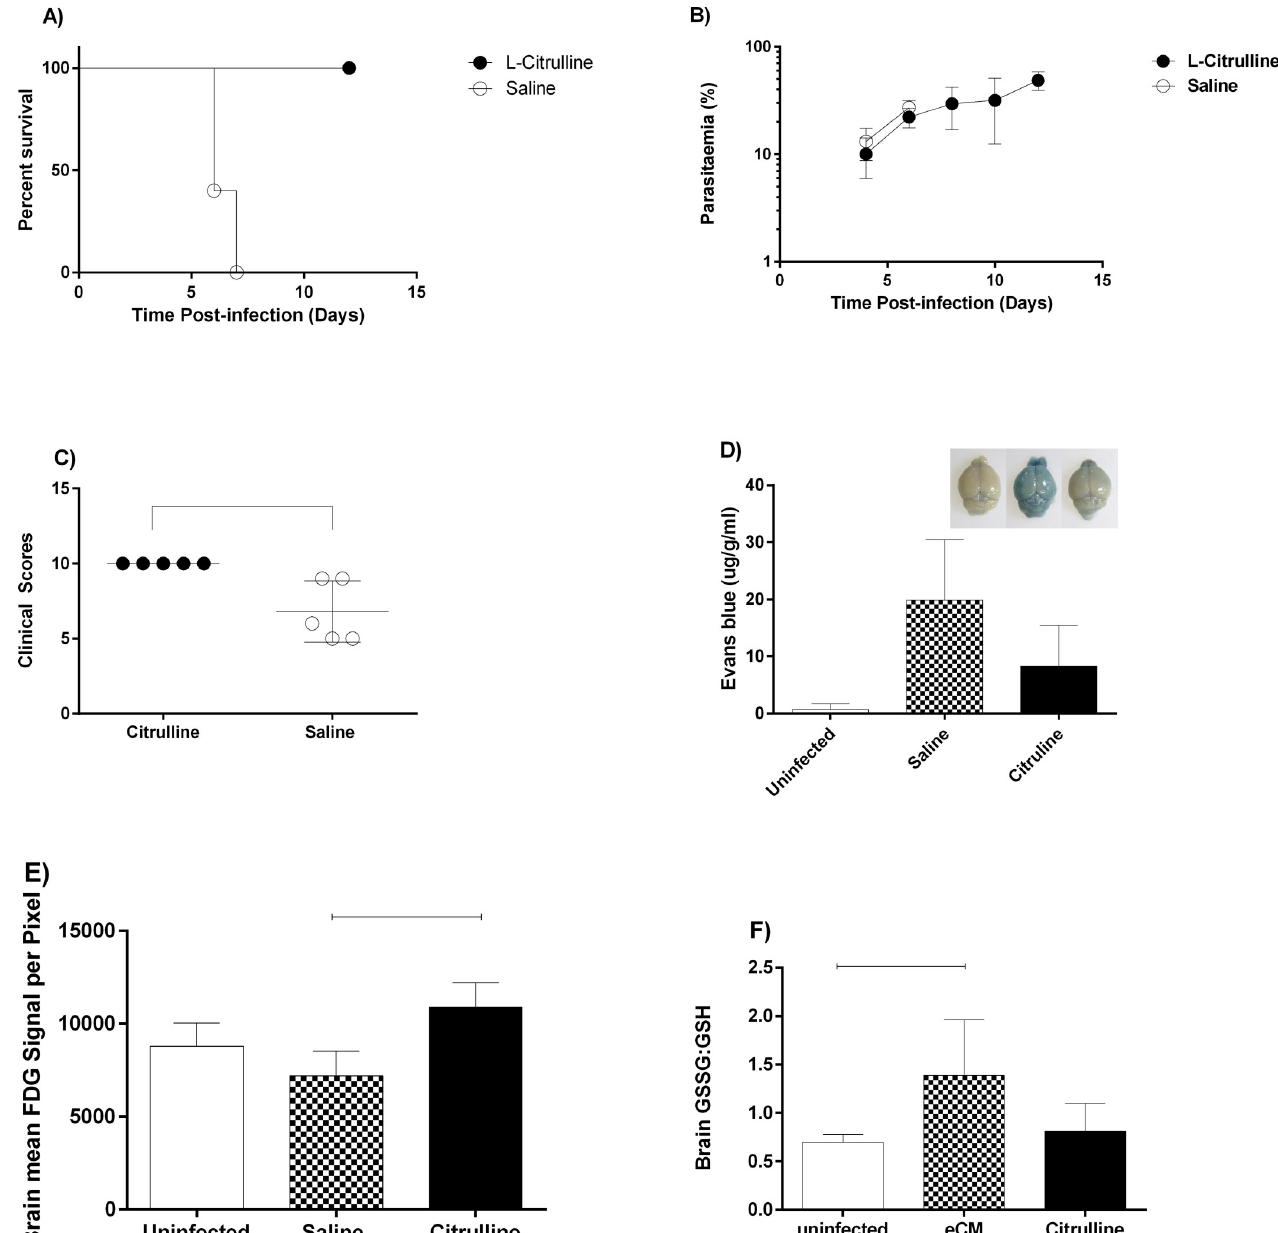
Fig 2. Citrulline as a nutraceutical protects against eCM. Groups (n = 5) of mice were injected i.v. with PbA and then injected twice daily ip with citrulline (nutraceutical) or saline. ( A): survival, ( B): parasitemia (mean % ± stderr) timecourse, and (C) : clinical scores of citrulline- and saline-injected mice infected with PbA. This experiment was repeated 4 times with similar results. Citrulline; Arginine (D): Vascular leak into brain measured by Evans Blue dye extrusion into brain parenchyma in groups (n = 5) of mice on day 6 PI (eCM) treated with citrulline as a nutraceutical or vehicle controls. Inset: representative images of brains after Evans Blue extrusion. This experiment was repeated with similar results. (E) : Average pixel intensity PET brain images in groups (n = 5) mice infected with PbA and treated with citrulline nutraceutical or saline and compared with uninfected controls. This experiment was performed once. : p < 0.05. (F) : Brain GSSG:GSH ratios in groups (n = 5) of mice infected with PbA and treated with Citrulline or saline twice daily i.p and compared to uninfected, untreated controls. Analysis performed by Metabolon inc (Morrisville, NC) using mass spectrometry.